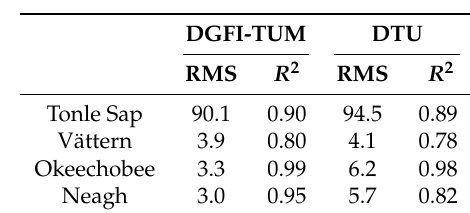
Table 3. RMS differences (cm) and squared correlation coefficients ( R 2 ) of the DGFI-TUM and Technical University of Denmark (DTU) water level time series with respect to in-situ gauging data at times where both methods produce